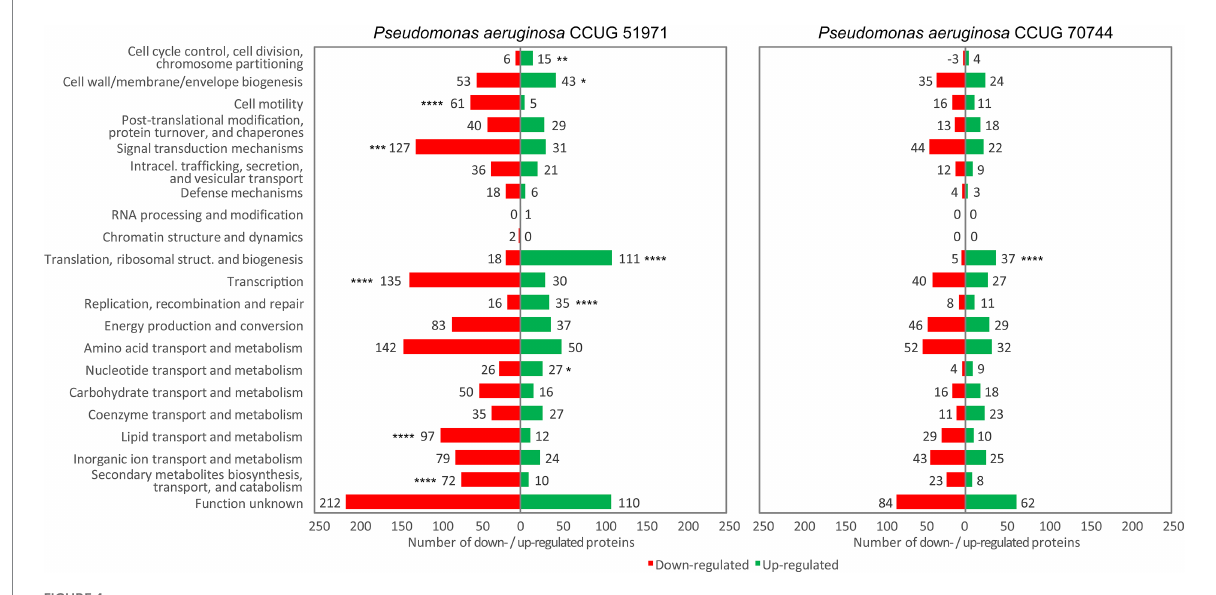
FIGURE 4 Functional classification (into COG categories) of the proteins that were upregulated or downregulated in the samples cultivated with the highest sub-MIC of Pseudomonas aeruginosa CCUG 51971 (256 μ g/ml) and CCUG 70744 (8 μ g/ml). Significantly upregulated or downregulated COG categories are marked as follows: * if p -value < 0.05; ** if p -value < 0.005; *** if p -value < 0.001; **** if p -value <